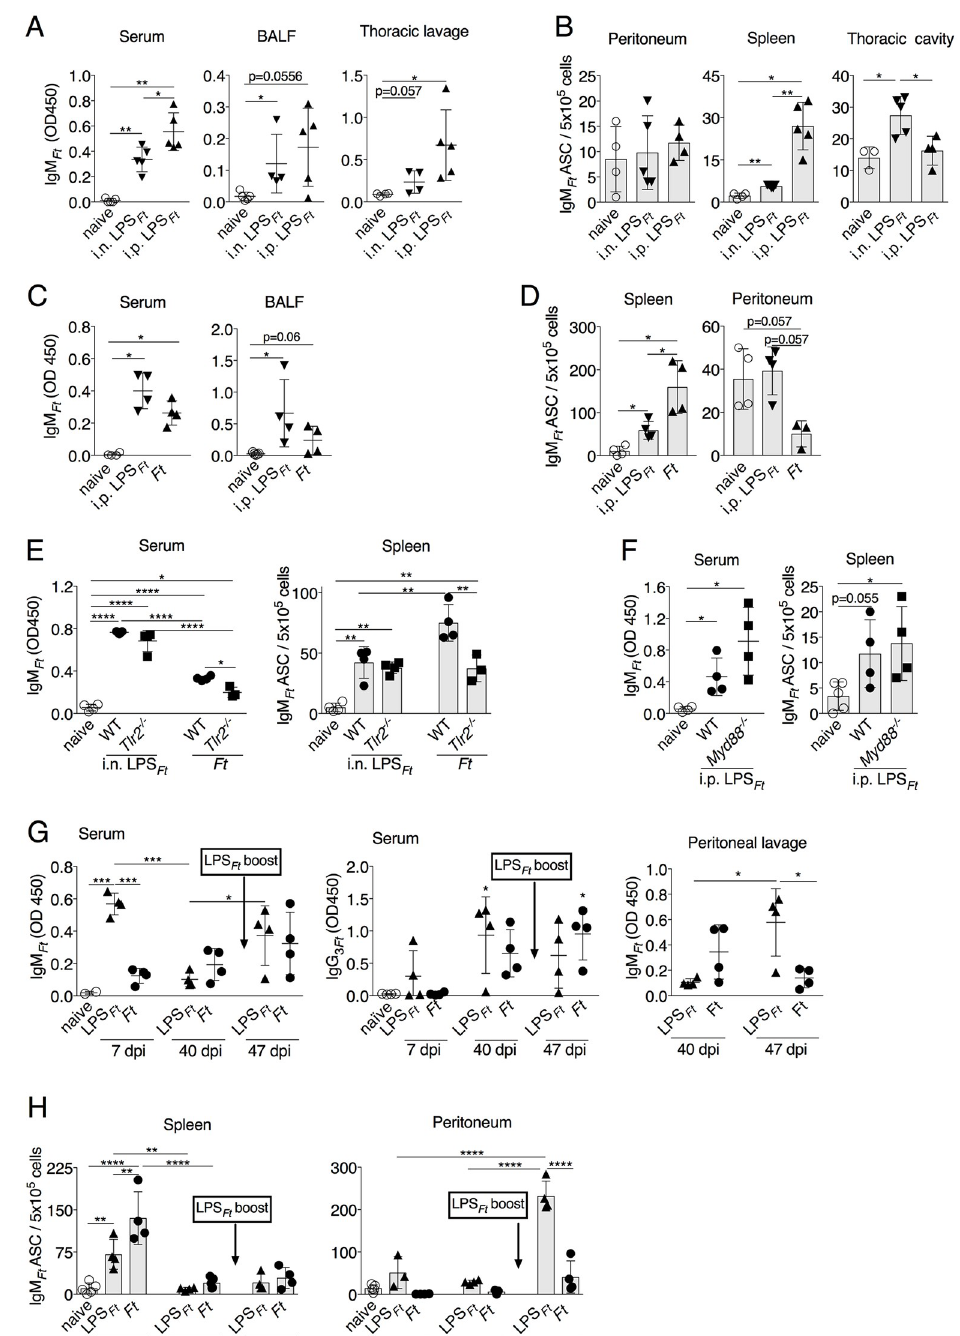
Fig 1. LPS elicits production of IgM independently of TLR2 or MyD88 and induces IgM memory B1 cells. Ft Ft (A-F) WT B6, Tlr2 -/- or Myd88 -/- mice were immunized intranasally (i.n.) or intraperitoneally (i.p.) with LPS Ft or infected i.n. with Ft (4x10 3 cfu). Seven days post-immunization IgM was measured in serum, BALF, or thoracic Ft cavity lavage (A, C, E, F) and IgM Ft ASC were enumerated by ELISPOT (B, D, E, F). (G, H) Groups of WT B6 mice were immunized i.p. with LPS or infected i.n. with Ft (4x10 3 cfu) and euthanized at the shown time points for Ft measurement of IgM Ft or IgG 3 Ft in serum and peritoneal lavage and enumeration of IgM Ft ASC. On day 40 post- immunization, groups of mice received an i.p. LPS Ft booster shot and were euthanized seven days later (day 47). One representative experiment of five (A, D), two (E-H) is shown. Data are expressed as mean ± SD. A-D, F, Mann- Whitney U test; E, G, H one-way ANOVA Tukey Post-test. � p < 0.05, �� p < 0.01, ��� p < 0.001, ���� p < 0.0001. See also S1 Fig.